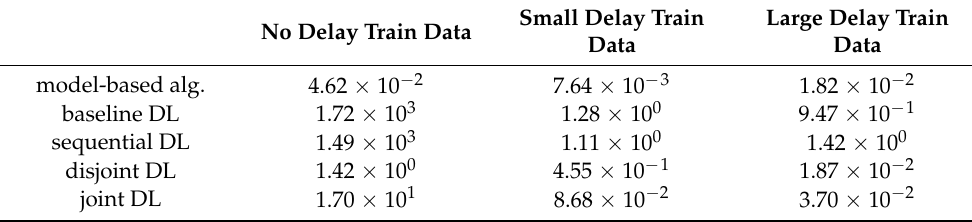
Figure 5. The mean square of disagreement and the mean square of the displacement from the leader position of the proposed DL consensus algorithms trained with different train data (max D is the maximum delay τ max ) ( a ) the mean square of disagreement—no delay train data; ( b ) the mean square of the displacement from the leader position—no delay train data; ( c ) the mean square of disagreement—small delay train data; ( d ) the mean square of the displacement from the leader position—small delay train data; ( e ) the mean square of disagreement—large delay train data; ( f ) the mean square of the displacement from the leader position—large delay train data. Table 3. Average mean square of disagreement over all simulation cases for different train